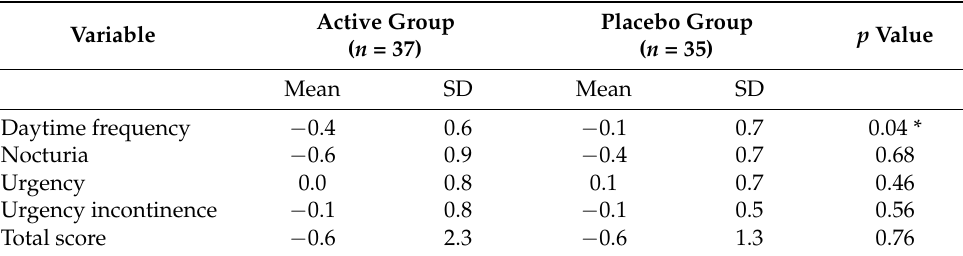
Table 4. Mean difference from the baseline for the overactive bladder symptom score (OABSS) in SPE treatment (active) and placebo